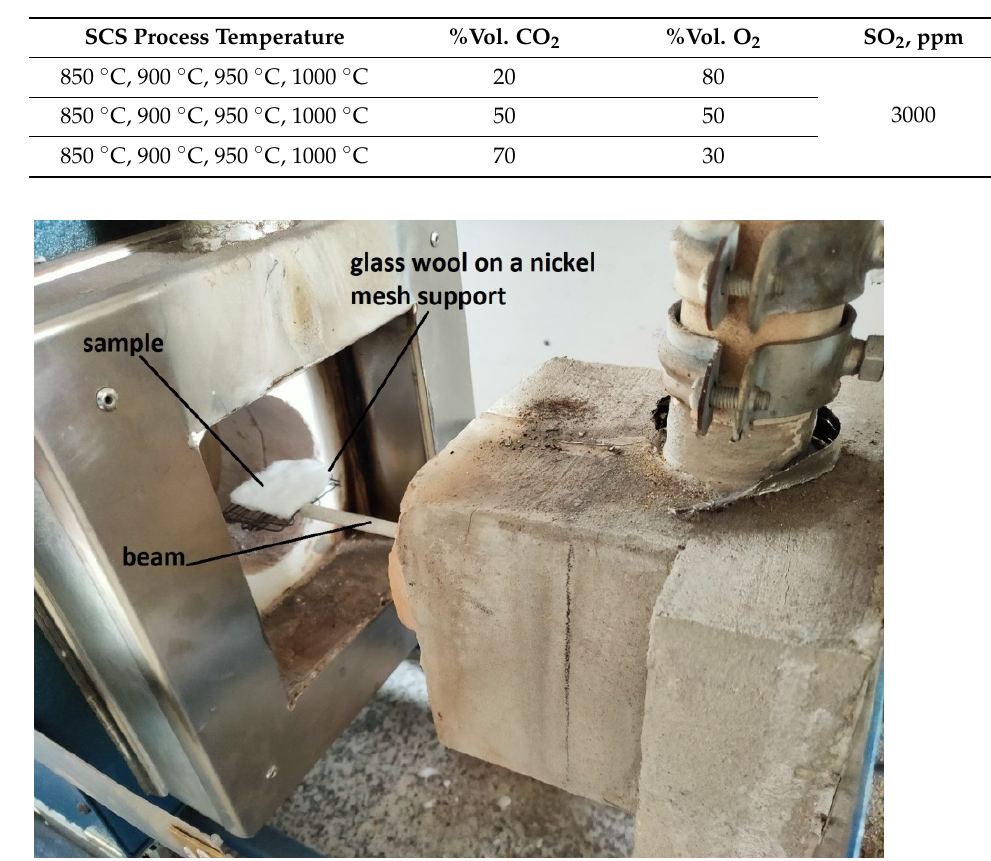
Figure 2. Method of placing a test sample on an electronic weighing pan [12].